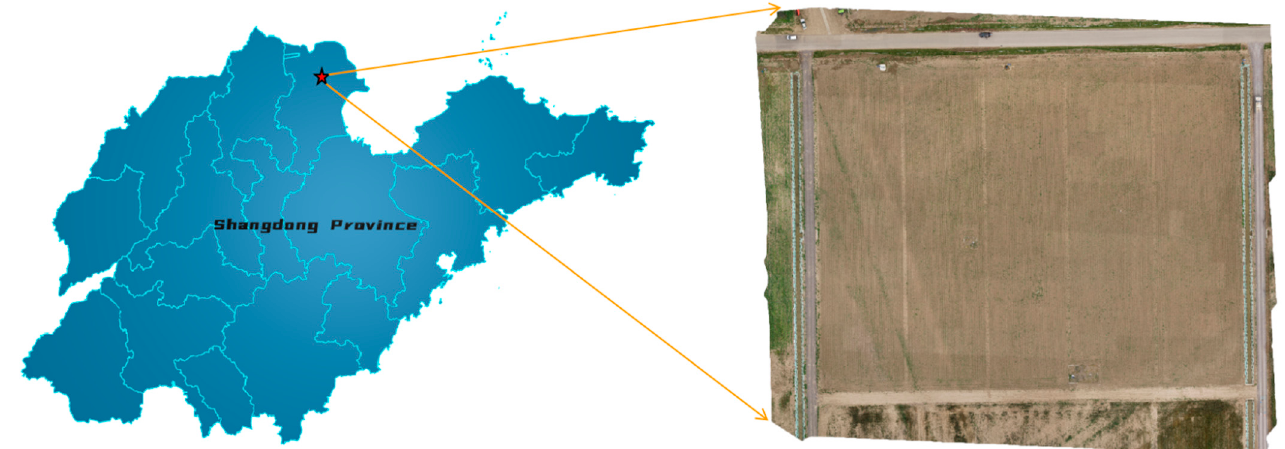
Figure 2. Image collected by the UAV in the Yellow River Delta Agricultural Hi-Tech Industry Demonstration Zone Dongying City, of Shangdong Province, China.